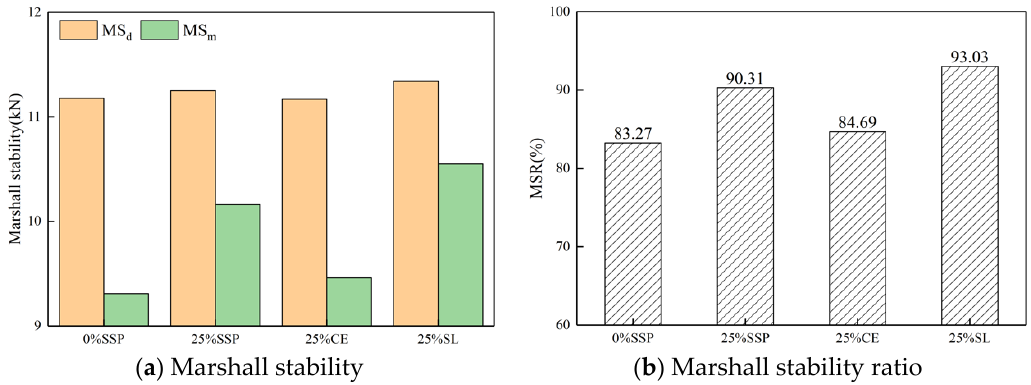
Figure 8. MS and MSR of samples with different fillers with the same substitution.